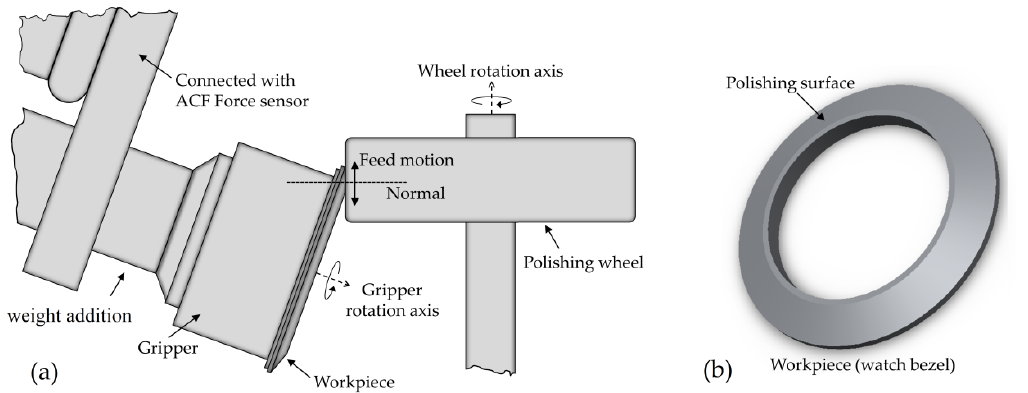
Figure 2. Polishing wheel and workpiece: ( a ) Top view of the polishing wheel and workpiece interaction; ( b ) isometric view of the workpiece (watch bezel).